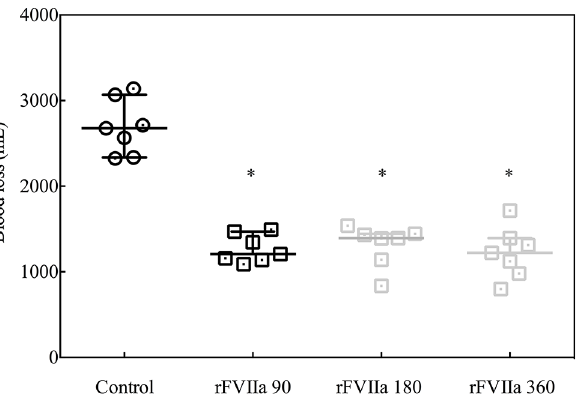
Fig 4. Total blood loss at the end of the observation period for animals not treated (control, black circles) or treated with 90 μ g/kg (black squares), 180 μ g/kg or 360 μ g/kg rFVIIa. * P < 0.05 rFVIIa versus control.